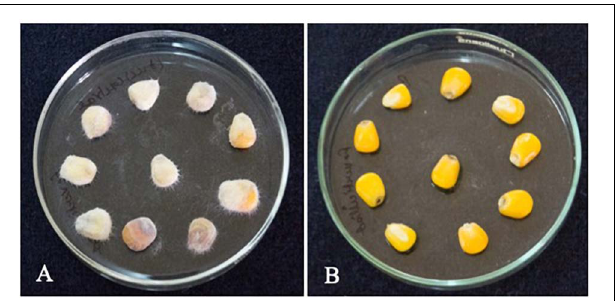
FIGURE 10 | Effect of L. brevis MYSN105-CFS treatment on maize kernels inoculated with F. verticillioides after 7 days. (A) Control, maize kernel infected with F. verticillioides ; (B) maize kernel treated with L. brevis MYSN105 CFS and infected with F. verticillioides .